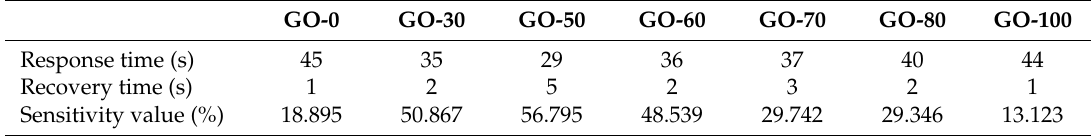
Figure 9. Dynamic resistance curves of graphite oxide samples prepared at different reaction temperatures. Table 2. Response/recovery time, sensitivity value of GO-X to 20 ppm NH 3 . Table 2. Response/recovery time, sensitivity value of GO-X to 20 ppm NH 3.